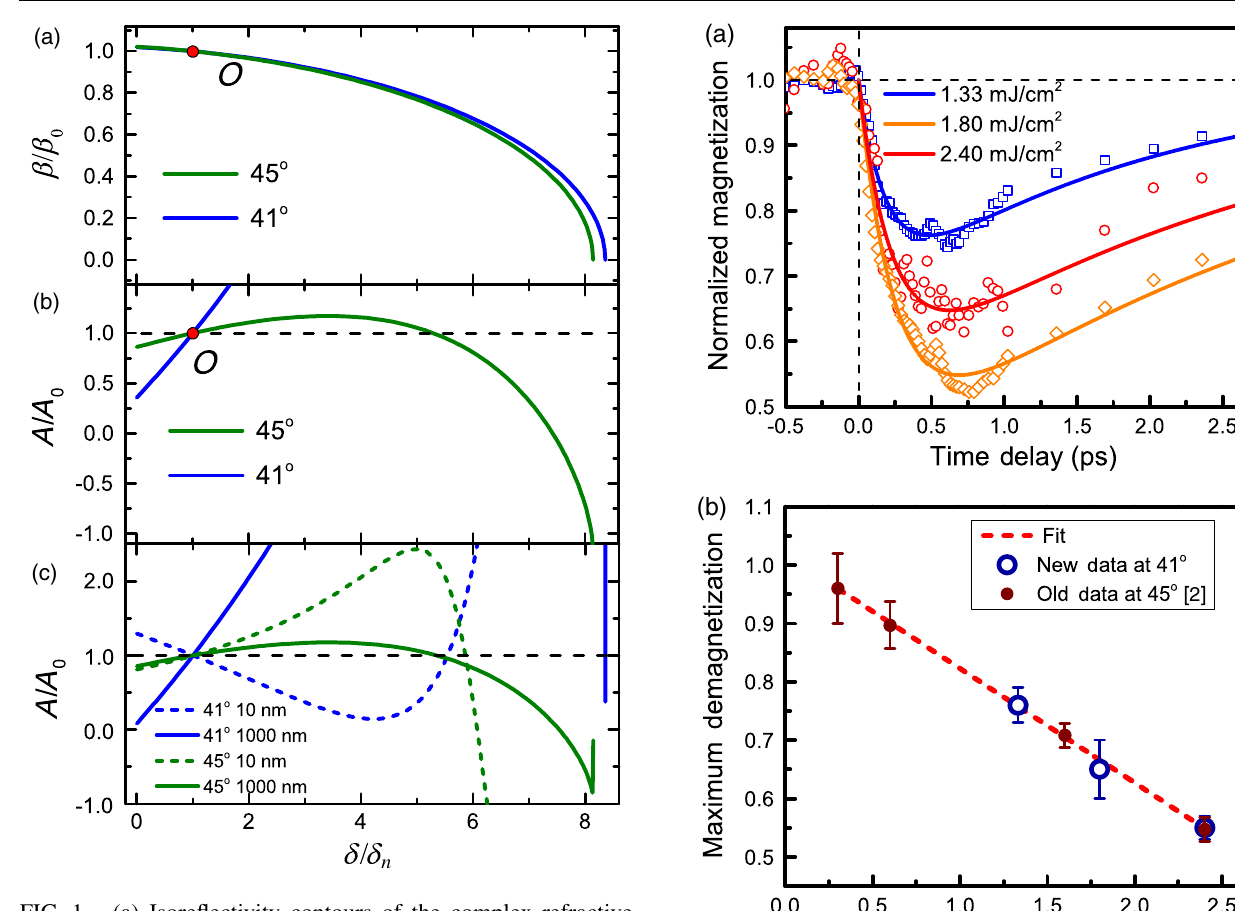
FIG. 1. (a) Isoreflectivity contours of the complex refractive index for R S ð (cid:1); (cid:2) Þ ¼ R S 0 at two angles of incidence of 41 (cid:1) and 45 (cid:1) , for comparison with Fig. 1(a) in the Comment by Vodungbo et al . (b) Calculated asymmetry parameter for 41 (cid:1) and 45 (cid:1) , subject to the same isoreflectivity constraint, in the semi-infinite limit. (c) Same as (b), but calculated with a con- ventional, self-consistent multilayer-reflectivity model, for both a thick (1000 nm) and thin film (10 nm) of Ni on 3-nm Ta. Movement of n away from point O , if restricted to the contours in (a), results in very different asymmetries for different angles of incidence. Experimentally, however, we do not observe any such dependence of the measured transient asymmetry on the incident angle (see Fig.